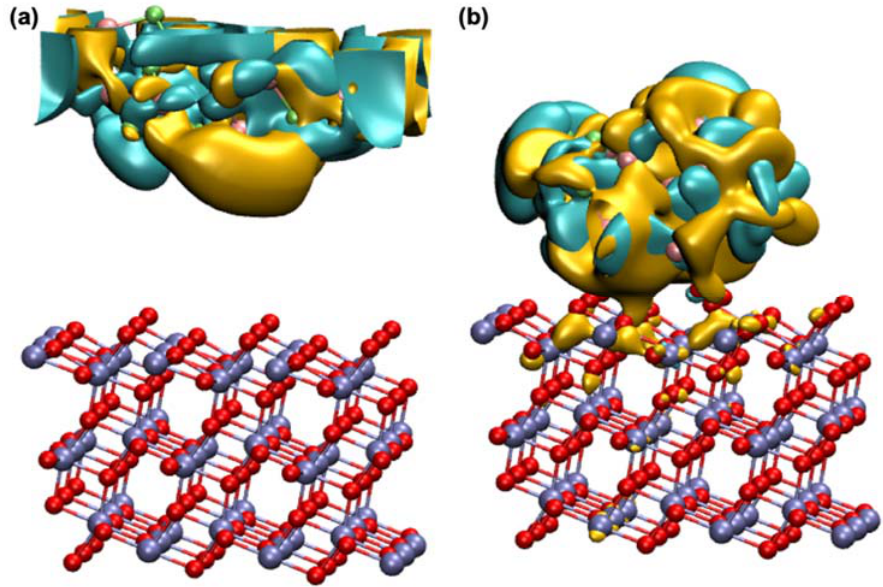
Figure 5. DFT optimized structures showing spatial positions of highest occupied molecular orbital (HOMO) and lowest unoccupied molecular orbital (LUMO) for TiO 2 (101) and HfN (111) are located at far ( a ) and close ( b ) configurations.